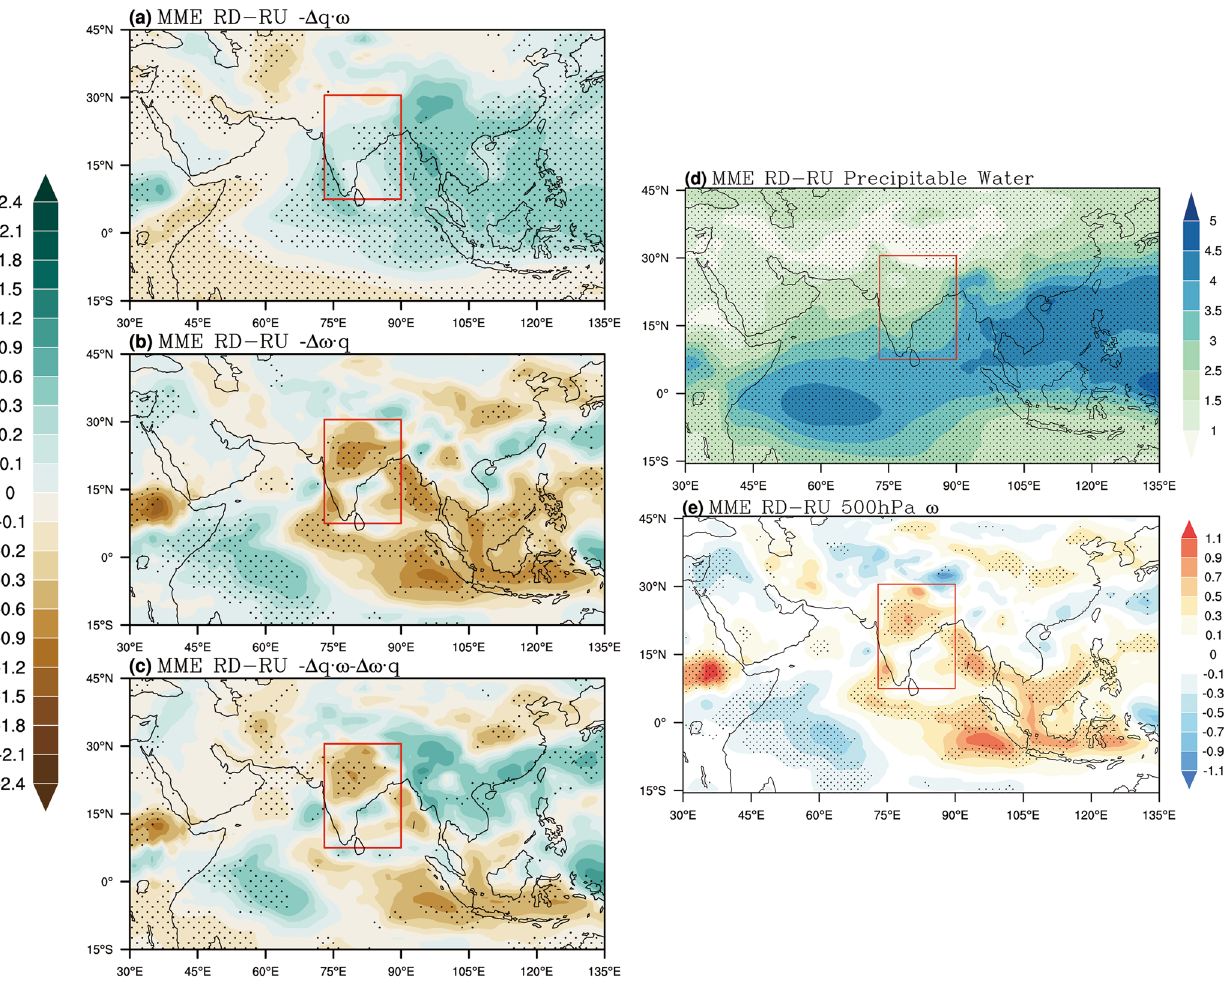
Fig. 4 The decomposition of the rainfall response. The difference in thermodynamic term ( a ), dynamic term ( b ), and both of them ( c ) between the RU and RD periods (unit: mm day − 1 ). d , e The same as in ( a − c ), but for the integration of speci fi c humidity from the surface to 1 hPa (unit: kg m − 2 ) and pressure velocity at 500 hPa (unit: 10 − 2 Pa s − 1 ). The black dots denote the region in which at least 70% of models agree on the sign of the MME. The red rectangles highlight the SASM region.